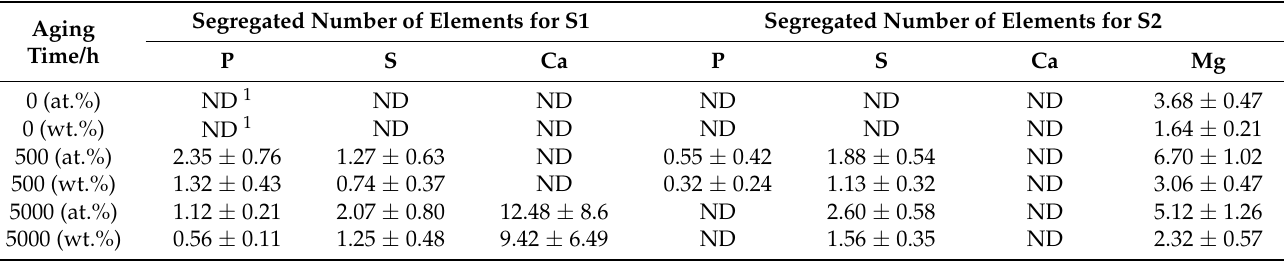
Table 3. Grain boundary segregation number of elements of P, S, Mg, and Ca in S1 and S2 samples aged at 580 ◦ C for different